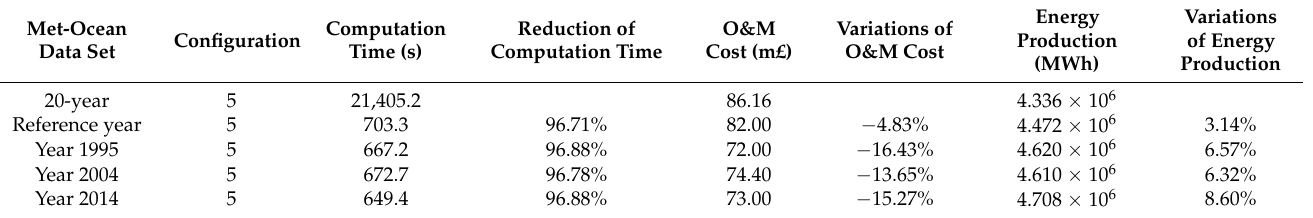
Table 5. O&M simulation results of the met-ocean reference year and the baseline individual